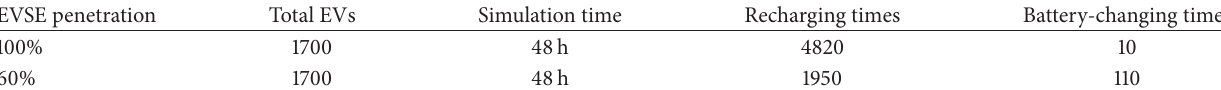
Table 2: Statistics of PEV traveling in the microgrid.